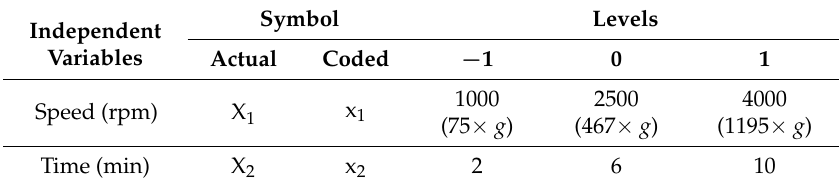
Table 3. Independent variable values of the centrifugation process and their corresponding levels.